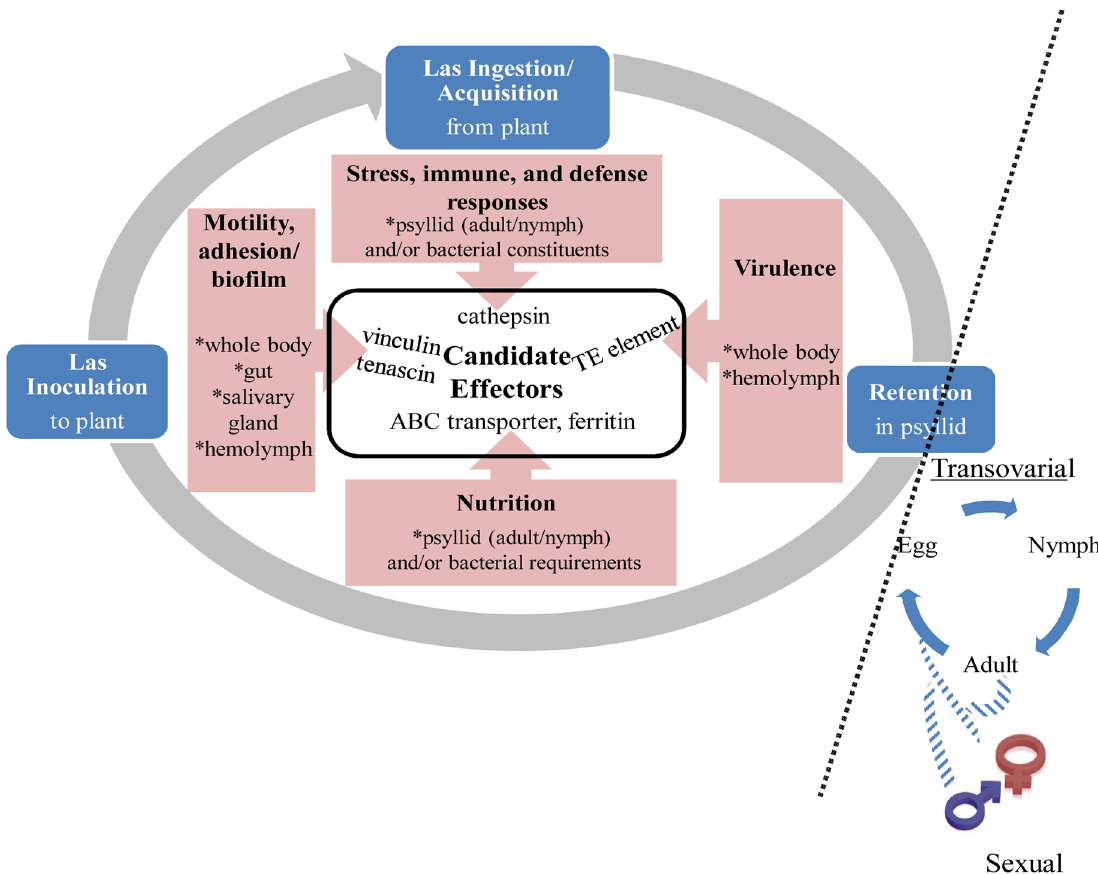
Fig 1. Proposed model of the circulative, propagative transmission pathway and selected hypothetical effectors involved in ACP responses to CLas infection, multiplication, circulation, and acquisition of ACP based on the comparative expression profiles.